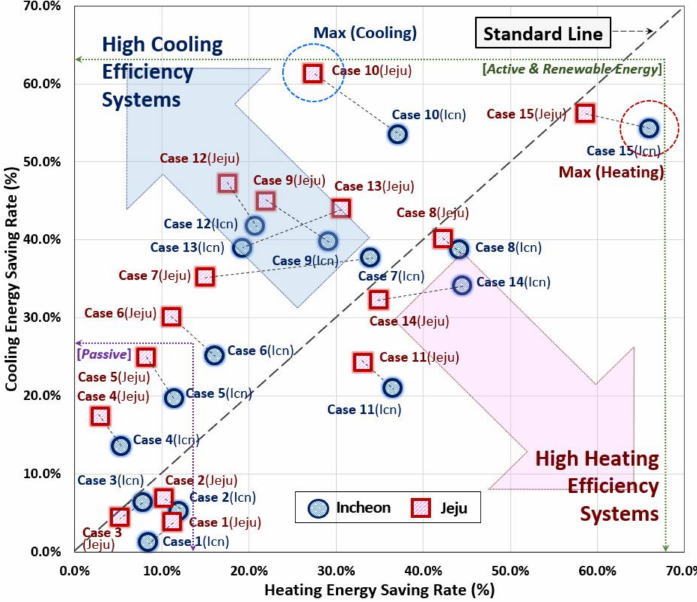
Figure 22. Cooling and heating efficiency system distributions of 15 cases (Incheon and